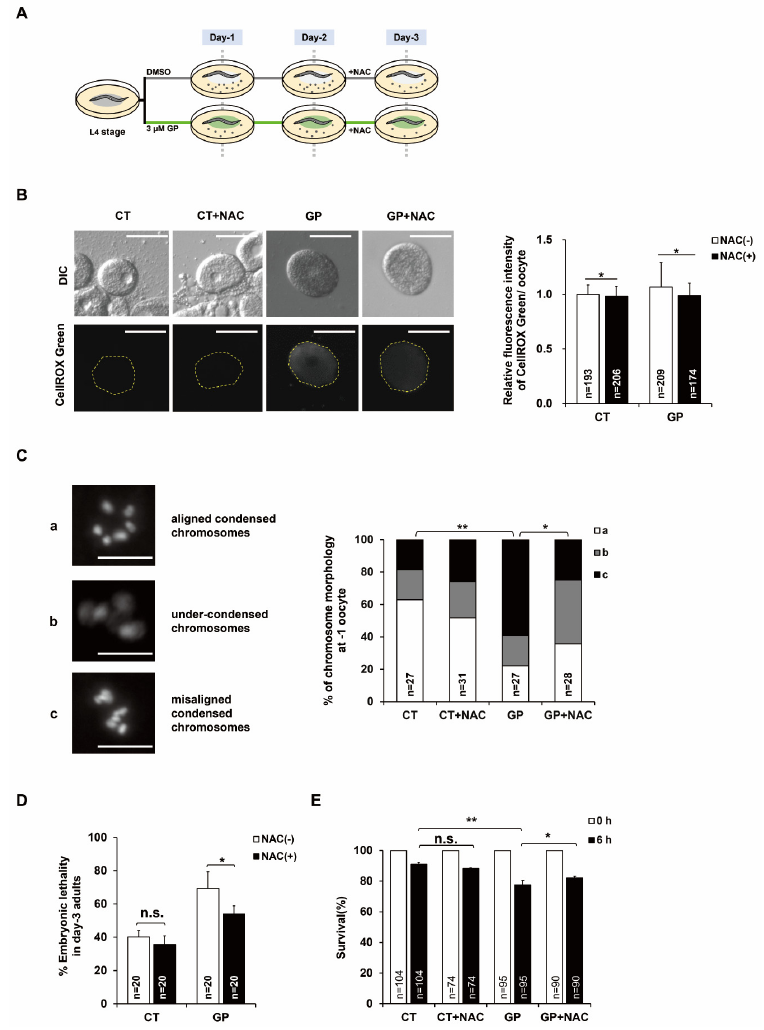
Figure 3. N-acetyl-L-cysteine (NAC) treatment suppresses effects of GP intake in adult C. elegans . ( A ) Experimental scheme of NAC treatment. The synchronized wild-type N2 worms at L4 stage